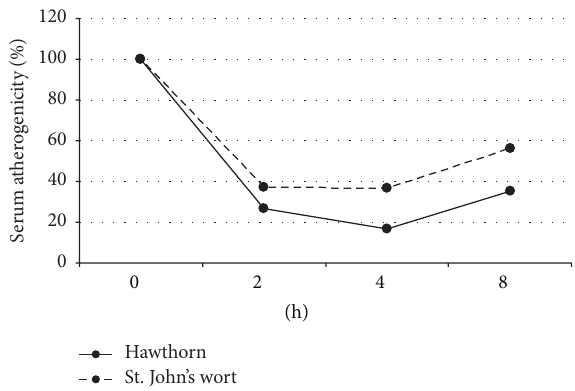
Figure 5: Study of serum atherogenicity in cellular assay. Four patients with atherosclerosis were given water extracts of 8 g of hawthorn berries or 3 g St. John’s wort herb. Blood samples were collected before treatment and after 2, 4, and 8 hours and blood serum was added to cultured primary subendothelial intimal cells. Serum atherogenicity was measured as the increase of cholesterol content in cultured cells after 24